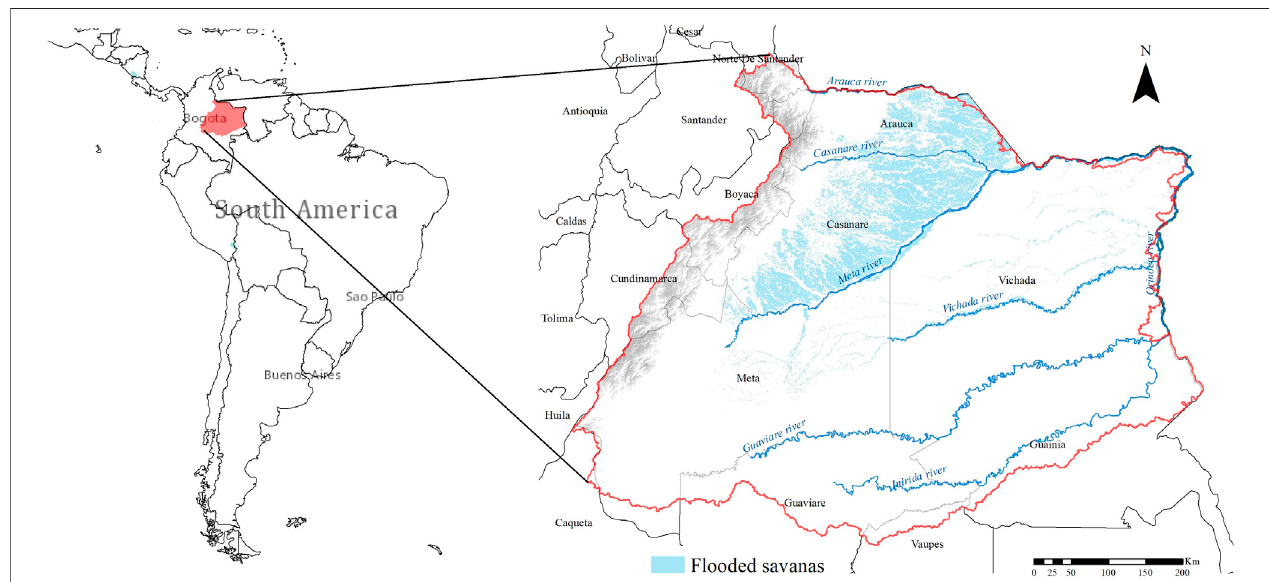
FIGURE 1 | Location of the Orinoco basin in Colombia. The watershed boundary is delimited by the red line. Flooded savannas are shown in light blue.